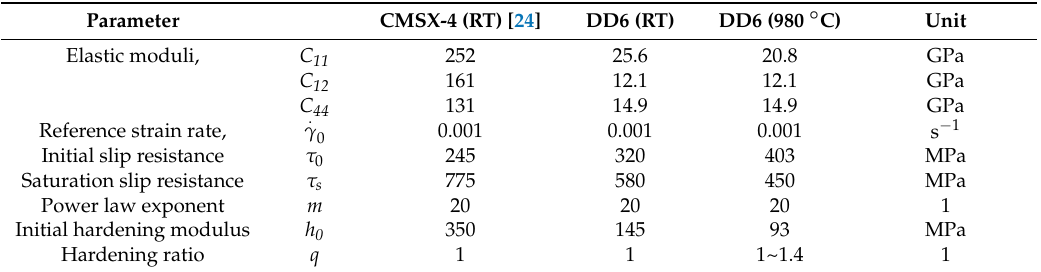
Figure 3. Stress-strain curves for quasi-static compressive test of [001] oriented SX samples. ( a ) DD6 and CMSX-4 superalloy deformed at room temperature with one slip mode activated; ( b ) DD6 deformed at 980 °C, with various slip modes activated. Table 5. Parameters used in crystal plasticity finite element method (CPFEM) simulations.